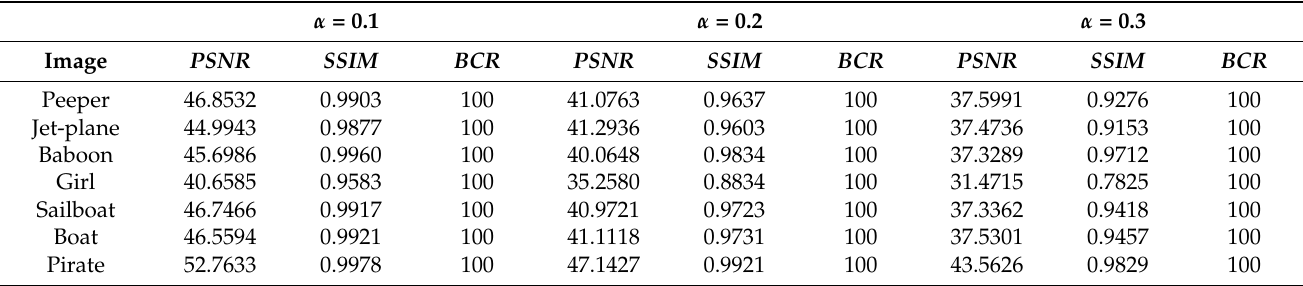
Table 3. PSNR (dB), SSIM , and BCR (%) measurements using different values of gain factor α using a 256-bit random sequence.